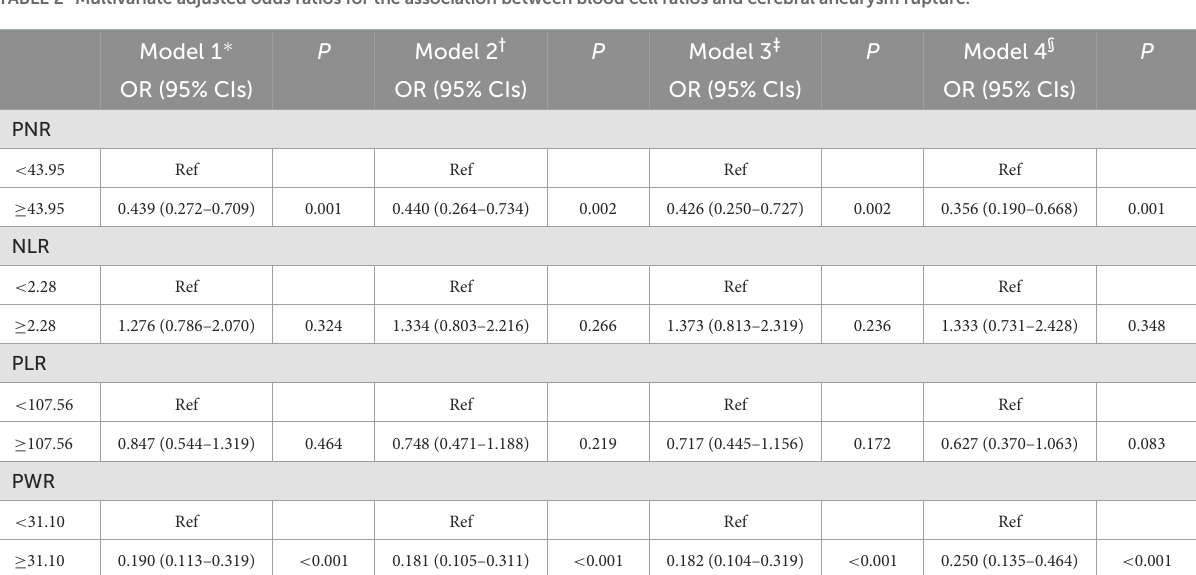
TABLE 2 Multivariate adjusted odds ratios for the association between blood cell ratios and cerebral aneurysm